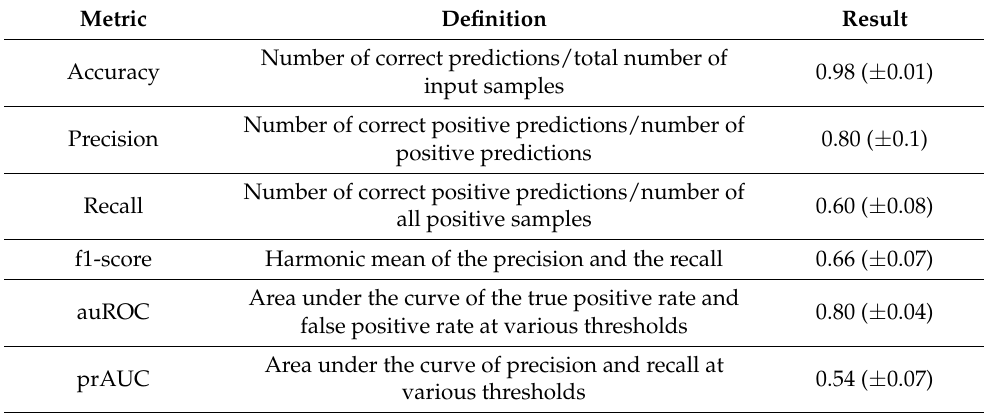
Table 2. Performances of the survival model evaluated with the bootstrap method on the test